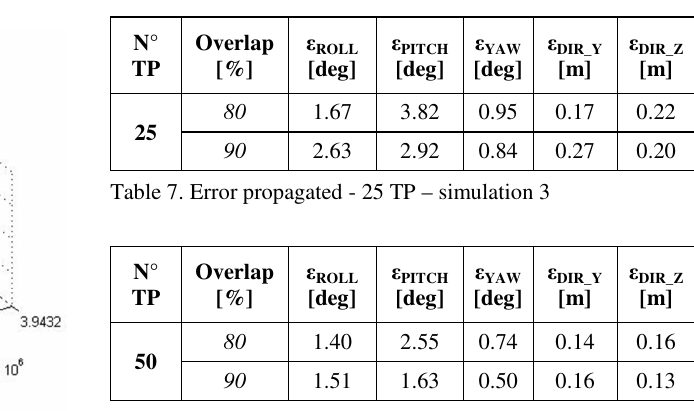
Table 8. Error propagated – 50 TP – simulation 3